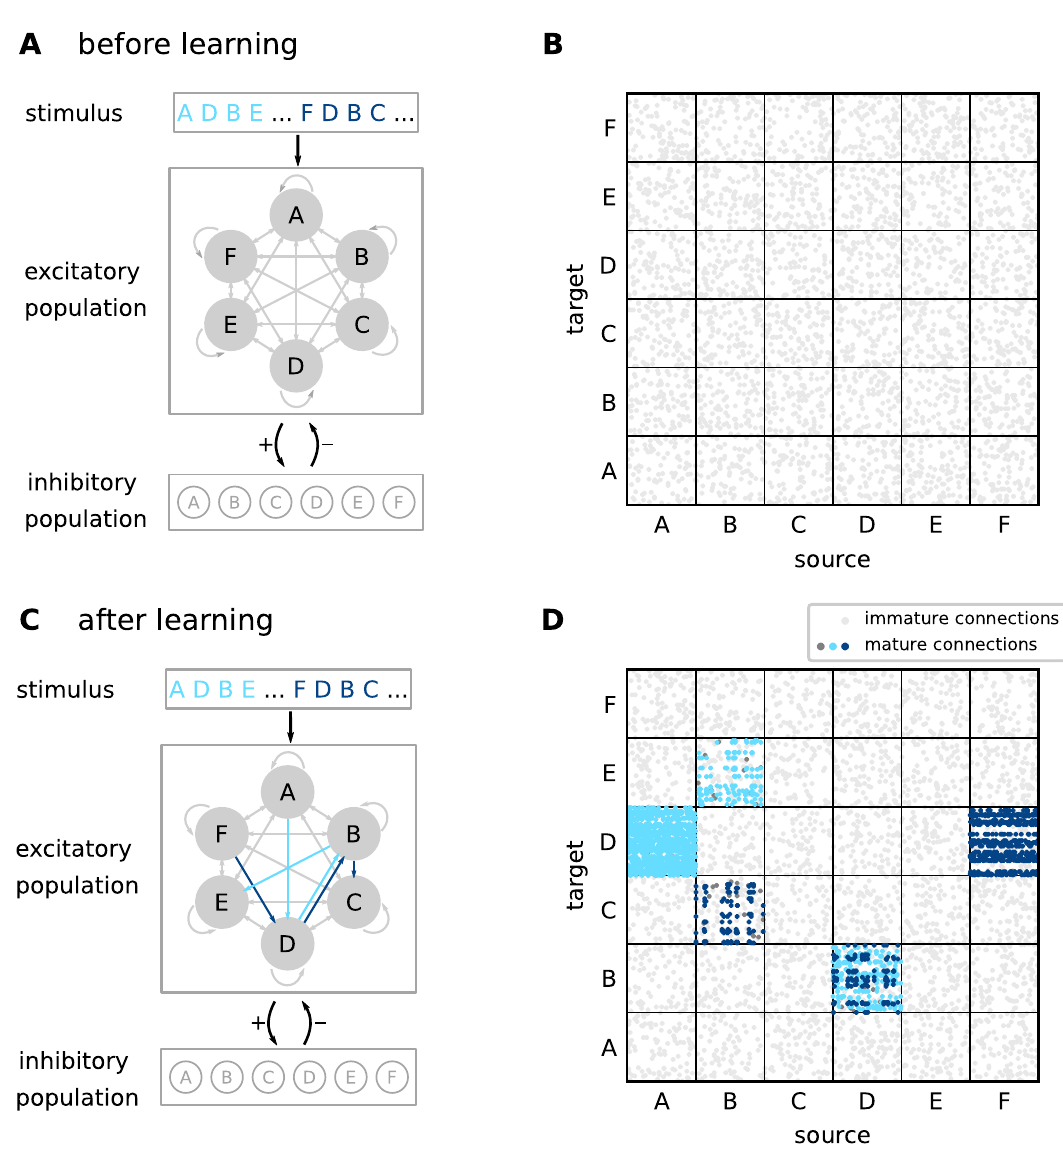
Fig 2. Sketch of the network structure. A) The architecture constitutes a recurrent network of excitatory and inhibitory neurons. Excitatory neurons are stimulated by external sources providing sequence-element specific inputs “A”,“D”, etc. The excitatory neuron population is composed of subpopulations containing neurons with identical stimulus preference (gray circles). Connections between and within the excitatory subpopulations are random and sparse. Inhibitory neurons are mutually unconnected. Each neuron in the inhibitory population is recurrently connected to a specific subpopulation of excitatory neurons. B) Initial connectivity matrix for excitatory connections to excitatory neurons (EE connections). Target and source neurons are grouped into stimulus- specific subpopulations (“A”, ... ,“F”). Before learning, the excitatory neurons are sparsely and randomly connected via immature synapses (light gray dots). C) During learning, sequence specific, sparsely connected subnetworks with mature synapses are formed (light blue arrows: {A, D, B, E}, dark blue arrows: {F, D, B, C}). D) EE connectivity matrix after learning. During the learning process, subsets of connections between subpopulations corresponding to subsequent sequence elements become mature and effective (light and dark blue dots). Mature connections are context specific (see distinct connectivity between subpopulations “D” and “B” corresponding to different sequences), thereby providing the backbone for a reliable propagation of sequence-specific activity. In panels B and D, only 5% of sequence non-specific EE connections are shown for clarity. Dark gray dots in panel D correspond to mature connections between neurons that remain silent after learning. For details on the network structure, see Tables 1 and 2.